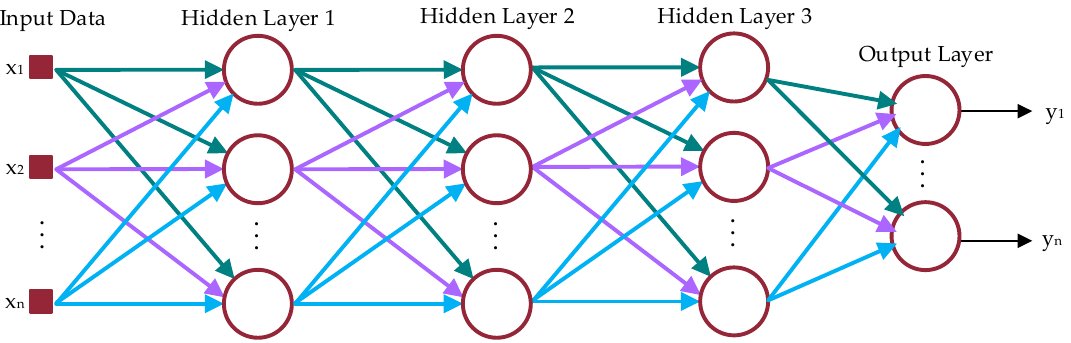
Figure 5. Sample structure of a feedforward network with three hidden layers.